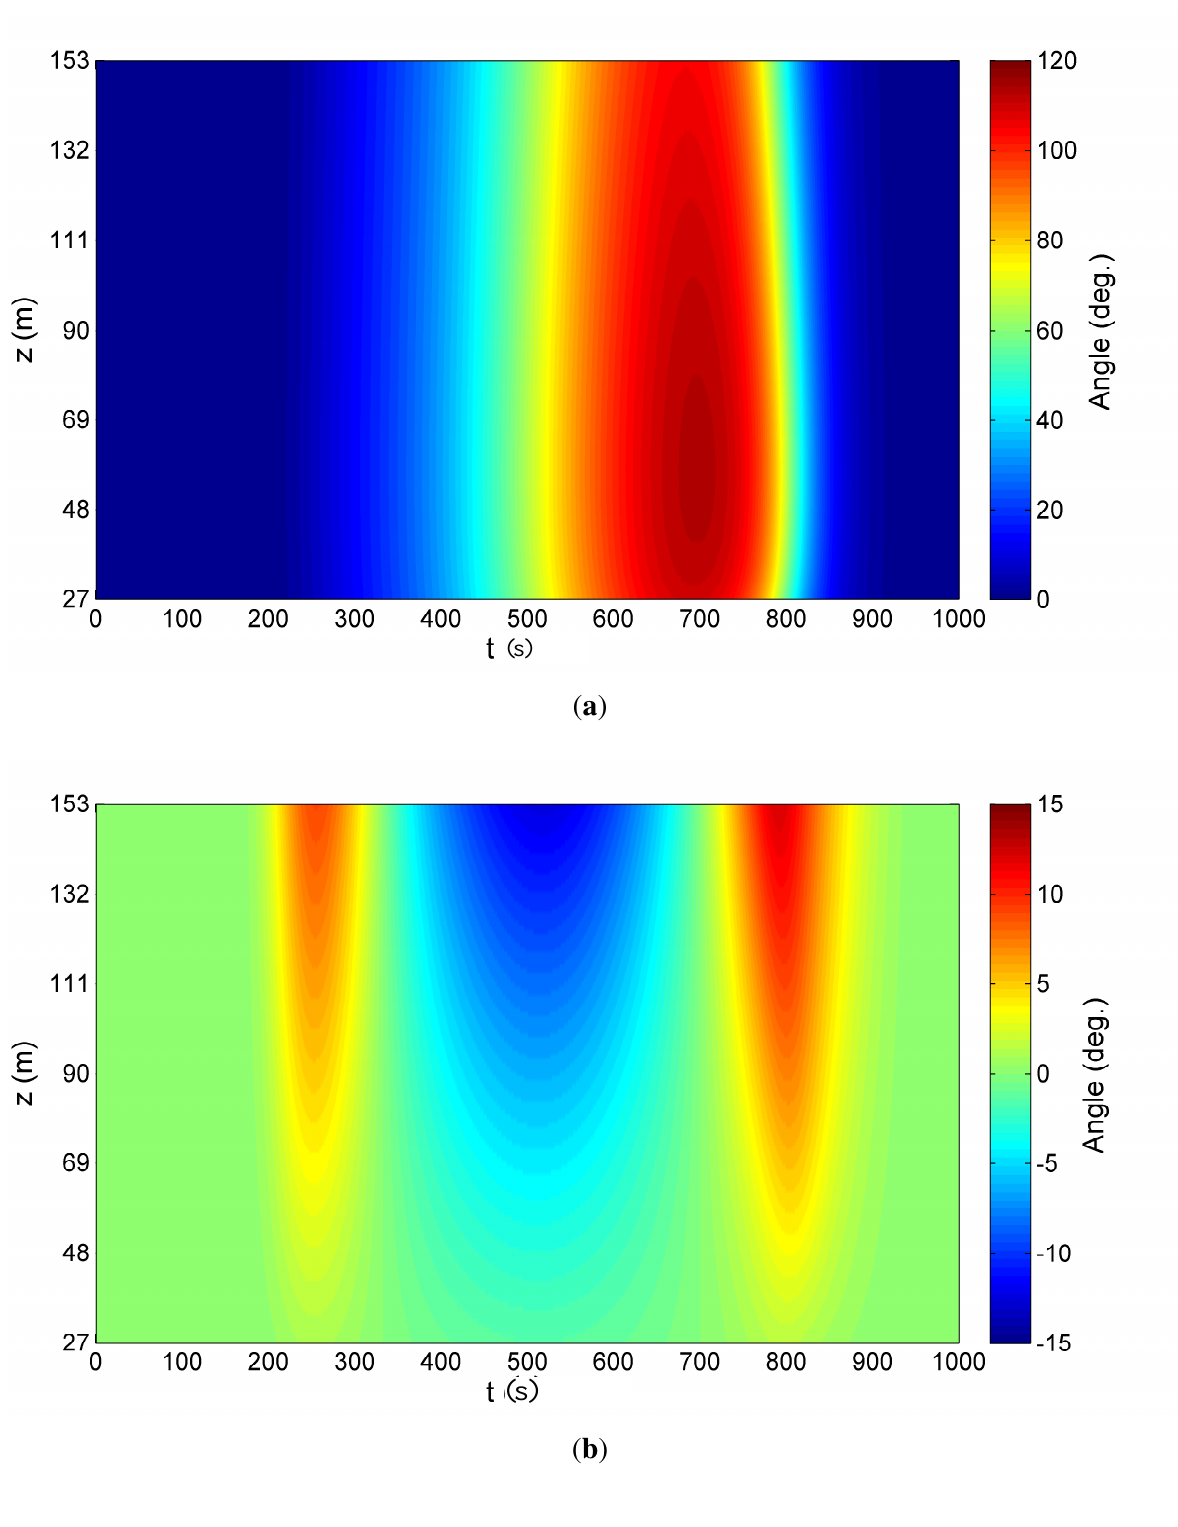
Figure 7. JAWS “Average”: non-turbulent veer profiles at turbine location (refer to Figure 8a. ( a ) Non-turbulent horizontal veer profile during the event; ( b ) Non-turbulent vertical veer profile during the